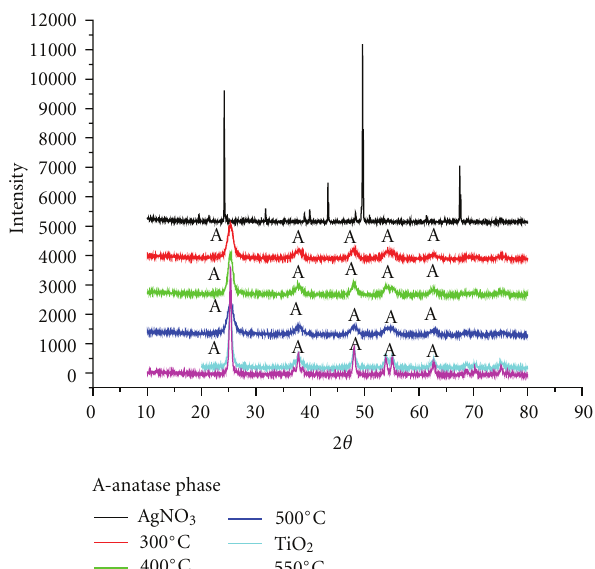
Figure 2: XRD pattern of prepared TiO 2 and Ag-TiO 2 with dif- ferent sintering temperature.